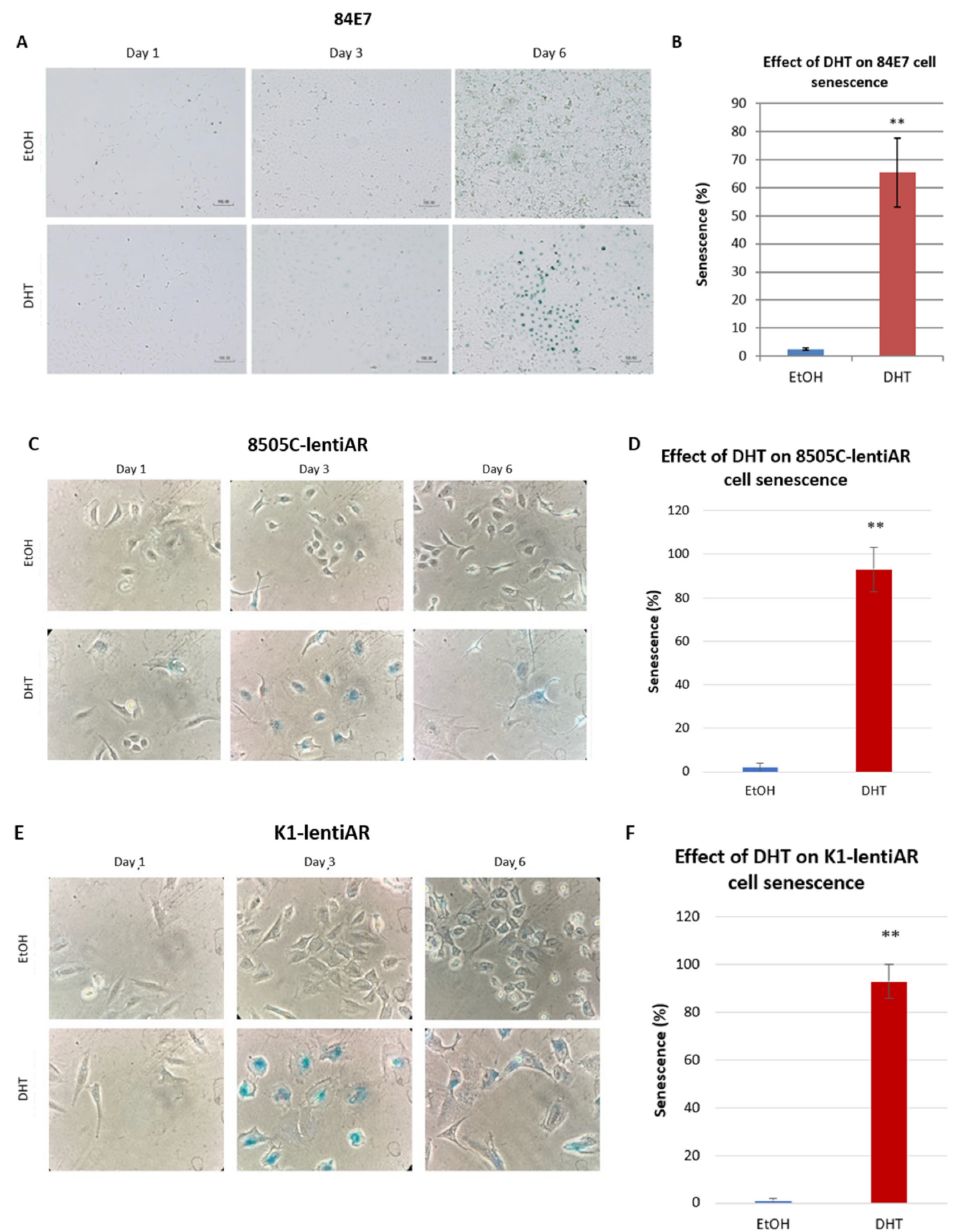
Figure 4. Effect of AR activation on SA β G accumulation: ( A ) AR activation of 84E7 drove significant SA β G accumulation. Top panel shows EtOH-treated 84E7 cells, which exhibited non-specific blue staining for beta-gal. Bottom panel shows blue staining of lysosomes in 84E7 cells treated with 10 nM DHT. ( B ) Quantification of increased senescence-associated beta-galactosidase expression in AR-activated 84E7 cells. ( C ) AR activation drove significant SA β G accumulation in 8505C-lentiAR when compared to EtOH-treated control cells. ( D ) Quantification of increased senescence-associated beta-galactosidase expression in AR-activated androgen-responsive 8505C-lentiAR cells. ( E ) AR activation drove significant SA β G accumulation in K1-lentiAR when compared to EtOH-treated control cells. ( F ) Quantification of increased senescence-associated beta-galactosidase expression in AR-activated androgen-responsive K1-lentiAR cells. The asterisks denote a statistically significant difference between the two groups (** p < 0.005). Images were taken at 20 × magnification ( A ) and 40 × magnification ( C , E